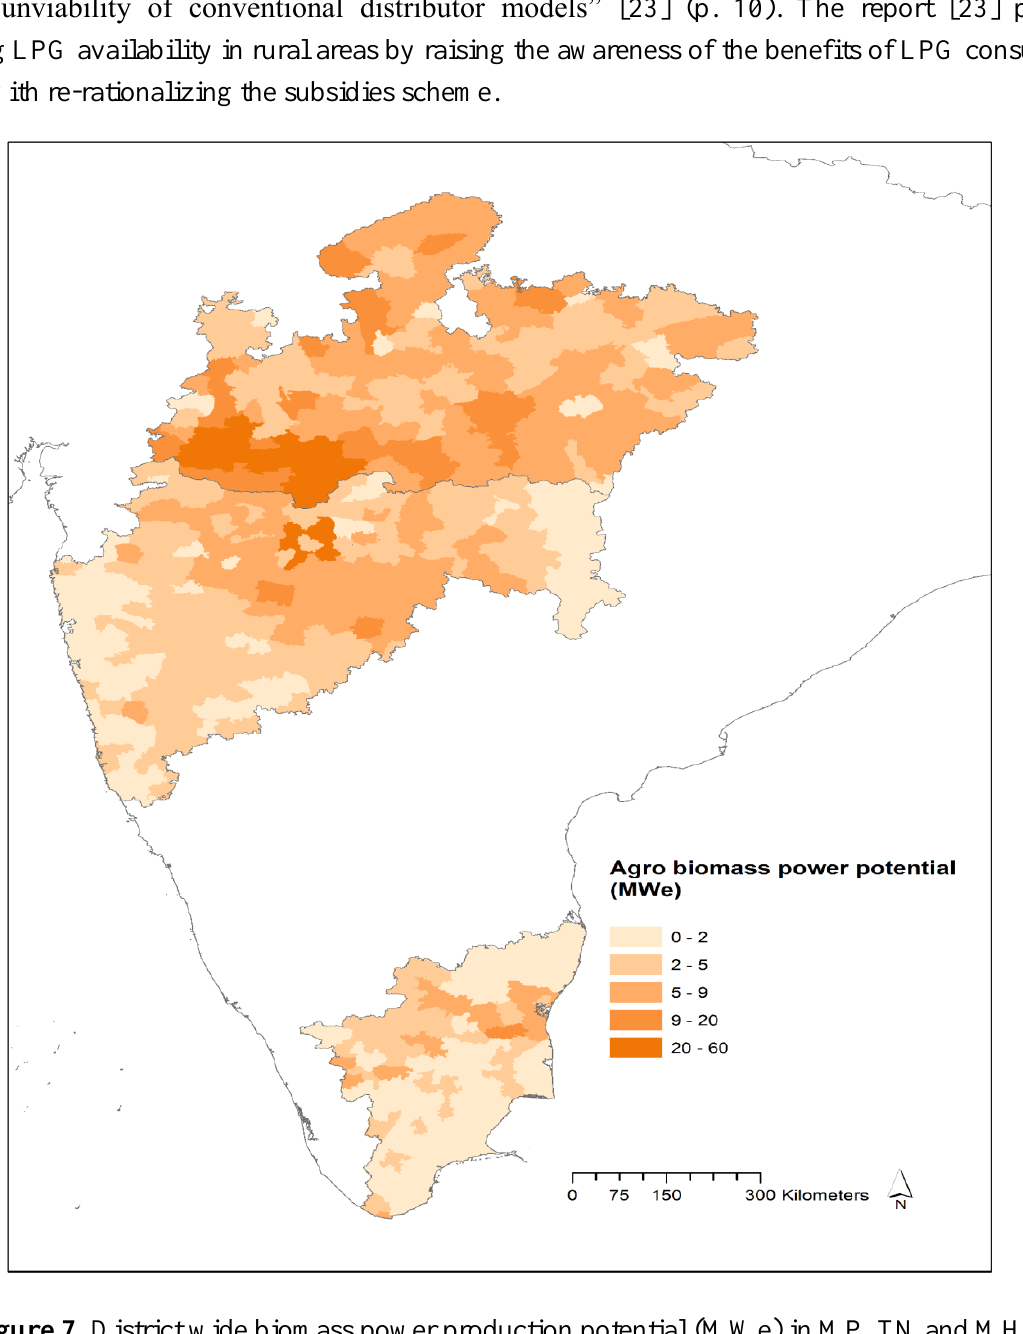
Figure 7. District wide biomass power production potential (MWe) in MP, TN and